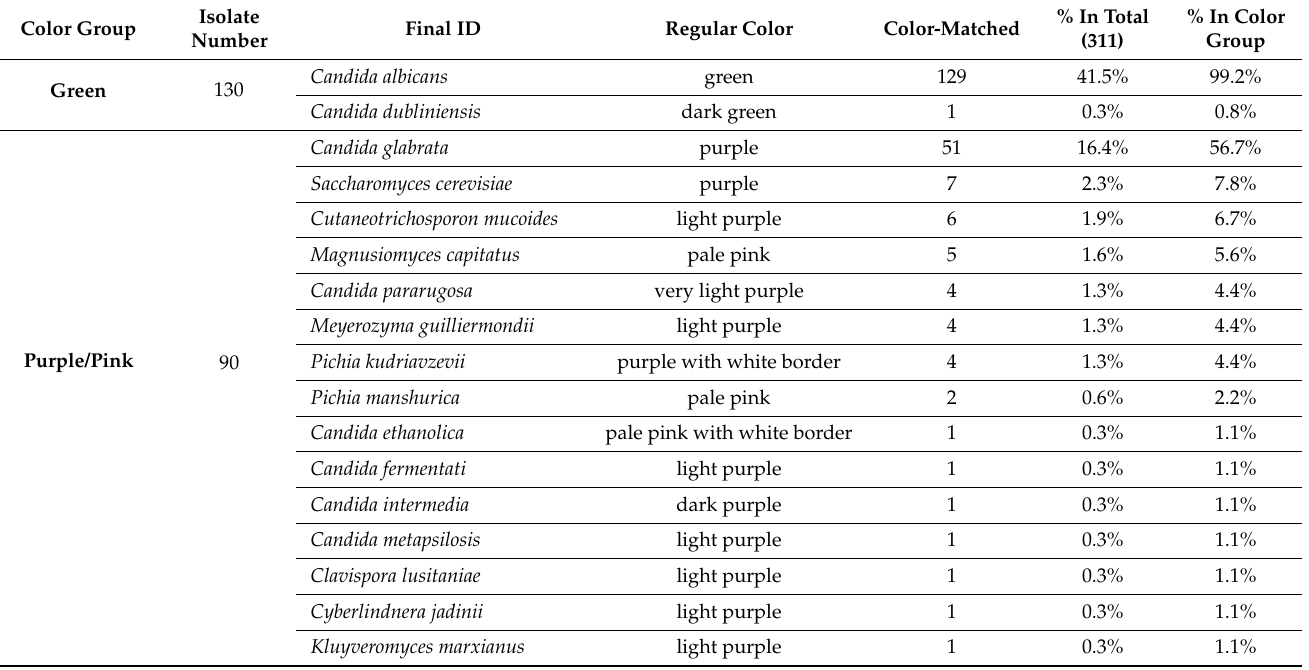
For all color-matched isolates, six color groups were identified: green, purple/pink, blue, white, gray, and orange. Almost all green colonies were C. albicans (129/130 isolates, 99.2%). C. parapsilosis accounted for more than 80% of the white group, and E. dermatitidis accounted for more than 70% of the gray colonies. In the blue color group, C. tropicalis (20/42 isolates, 47.6%) and T. asahii (18/42, 42.9%) were the main two species. In the purple/pink color group, there were 15 species, including fifty-one of C. glabrata , seven of S. cerevisiae , six of Cutaneotrichosporon mucoides (formerly Trichosporon mucoides ), five of M. capitatus , four each of C. krusei (teleomorph Pichia kudriavzevii ), C. pararugosa , and Me. guilliermondii (anamorph C. guilliermondii ), two of P. manshurica, and one each of C. fer- mentati , C. intermedia , C. ethanolica , C. metapsilosis , C. utilis (teleomorph, Cyberlindnera jad- inii ), Clavispora lusitaniae (anamorph C. lusitaniae ) , and Kluyveromyces marxianus (ana- morph, C. kefyr ) (Table 5). A wide range of species had a purple/pink color on CHRO- Magar Candida, but the most abundant species was C. glabrata (51/90, 56.7%) (Table 5). Table 5. Proportions of color-matched species on CHROMagar Candida plates.